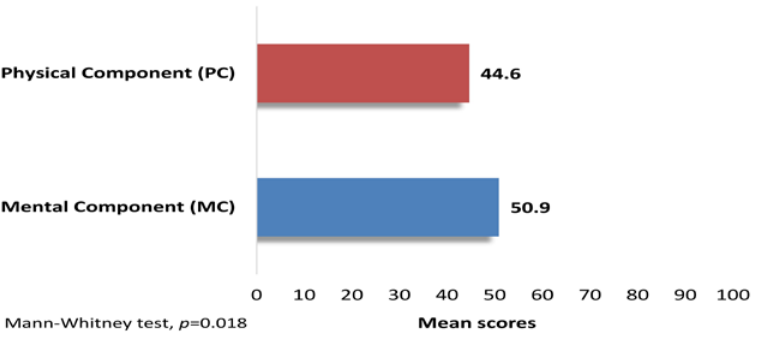
Figure 2. Comparison of scores of the two main components of the SF-36 QoL scale for the 83 study participants.